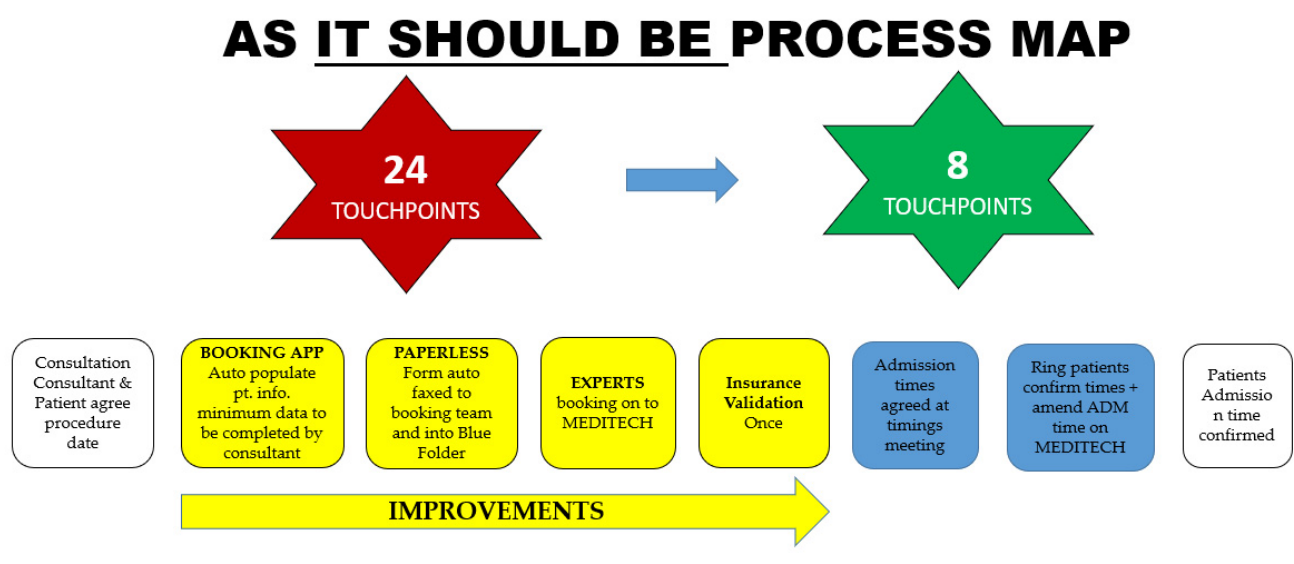
Figure 6. As it should be process.